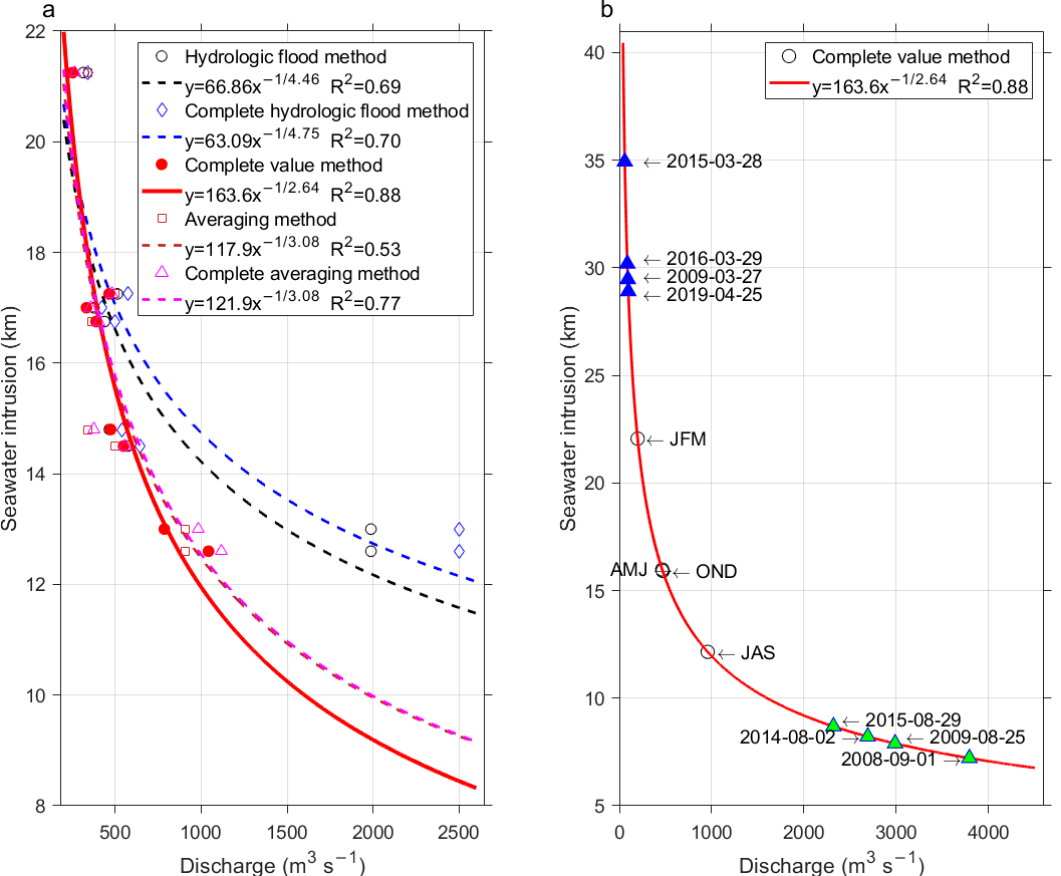
Figure 3. ( a ) Regression curves between the different measures of discharge(s) from the river(s) and saline water intrusions (average of ebb and flood type) in the VRE for the four seasons of the year under conditions of spring and neap tides applying power regression models. ( b ) The power regression curve that was obtained between the complete value method discharges and saltwater intrusions with a R 2 score of 0.88 extended to a discharge range of 0–4500 m 3 s − 1 . Long-term (2008–2019) seasonal averages of river discharges for January–March (JFM), austral summer, April–June (AMJ), austral autumn, July–September (JAS), austral winter, and October–December (OND), austral spring, are shown as circles. Extreme flow values are shown as triangles (minimums in blue and maximums in green). Table 3. Characteristics of the main harmonic tidal constituents at stations Lido and Valdivia. Harmonic